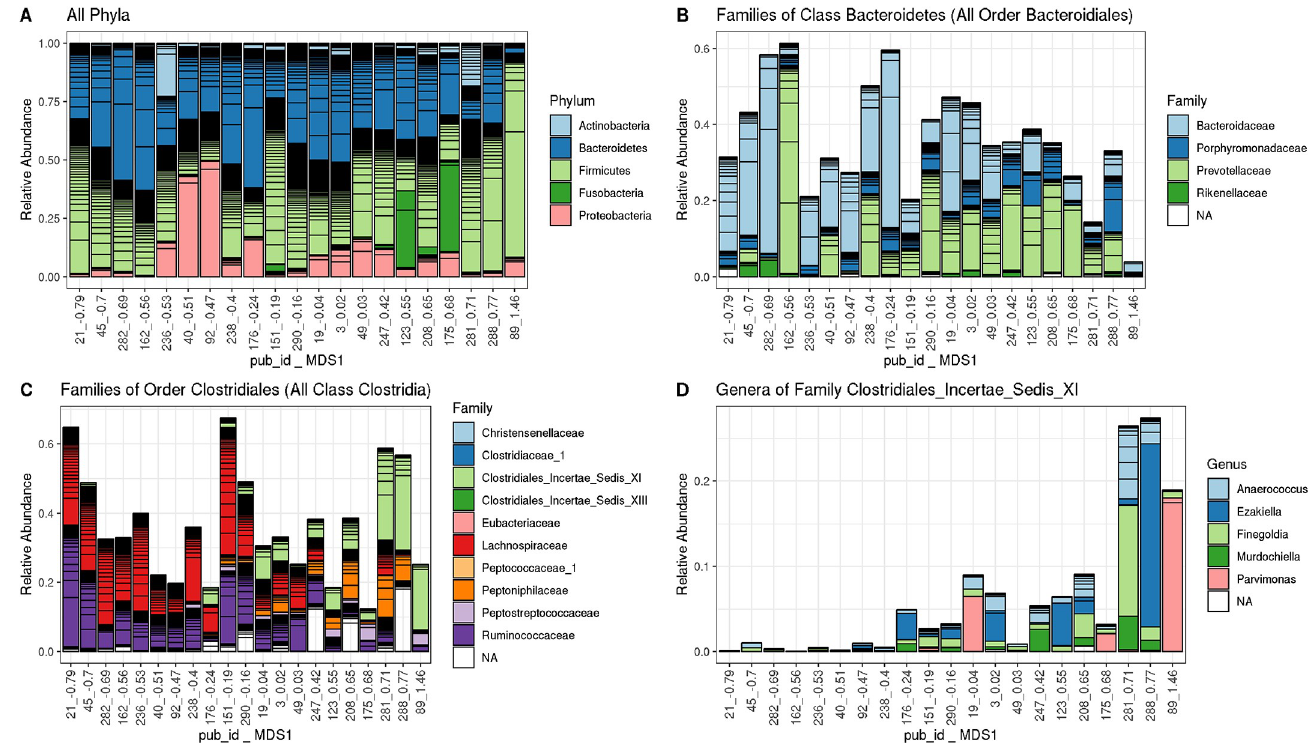
Fig 4. The microbiota vary between participants and can be described by weighted UniFrac axis 1 (MDS1). Variations along this axis are evident at the family level within certain classes and orders, but are less evident at the phylum or genus level. These stacked bar plots show relative abundance of taxonomic groups composing participants’ microbiota. In all cases participants are ordered from left to right according to where their microbiota falls along weighted MDS1 (Fig 2). A All taxa at phylum level. B. All families within Order Clostridiales, all of which fall within Class Clostridia. C. All families within Order Bactereoidales, all of which are in the Class Bacteroidetes. D. Genera within the family Clostridiales Incertae Sedis XI.